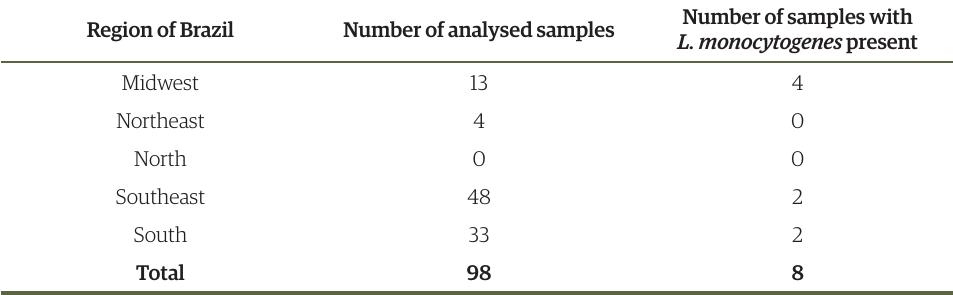
Table 1. Distribution of samples and results for L. monocytogenes in sausage samples according to geographic region in